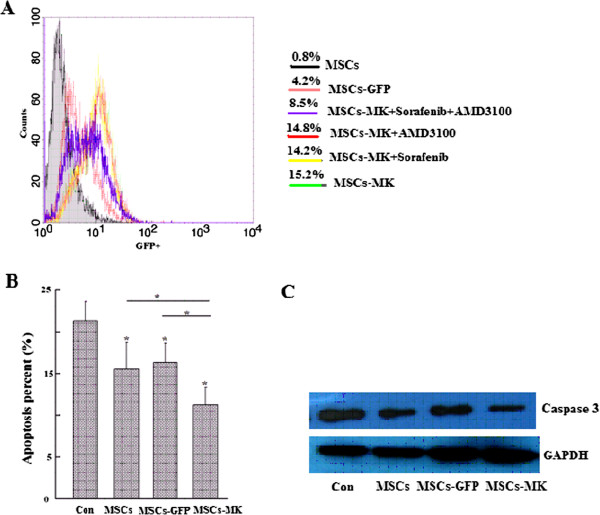
MK increased the protective effects of MSCs on H9C2 cells. A: Flow cytometry analysis of the proportion of GFP + cells in the bottom hypoxic H9C2 wells. B: Protective effects of MSCs, MSCs-GFP and MSCs-MK on hypoxic H9C2 cells, measured by Annexin V-PE/7AAD staining. The graph shows the percentages of Annexin V-PE + and 7AAD + (apoptotic) cells as the means ± SEM for three independent experiments. C: Caspase-3 activity of H9C2 was analyzed by Western blot. MSCs-GFP, Mesenchymal stem cells-green fluorescent protein; MSCs-MK, Mesenchymal stem cells-midkine.